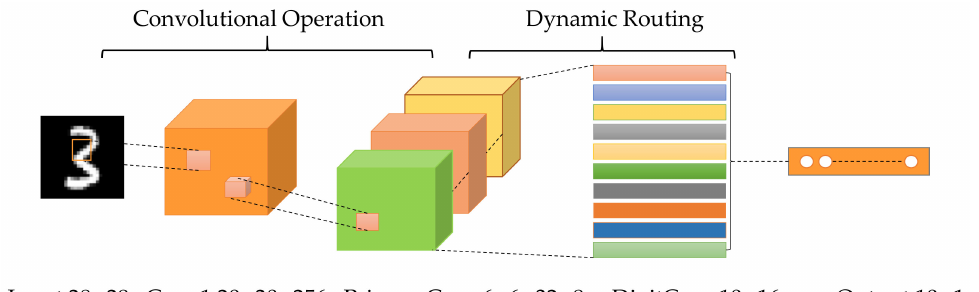
Figure 1. Architecture of a capsule network with three